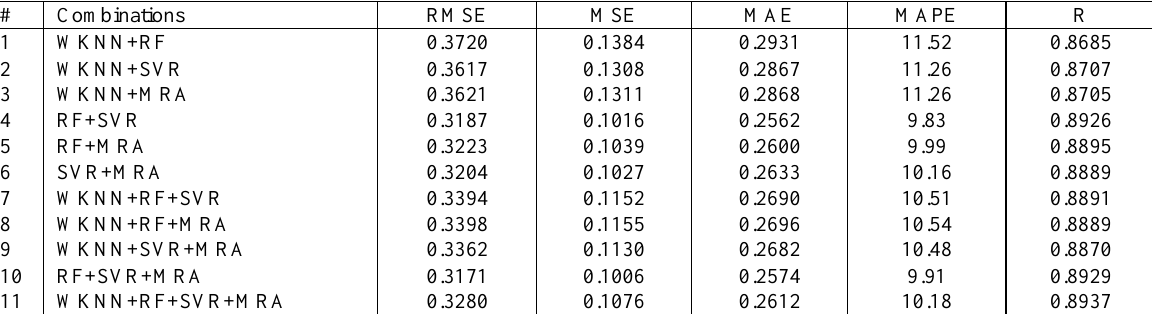
Table 5 . Evaluation criteria of combination the basic models based upon the Voting